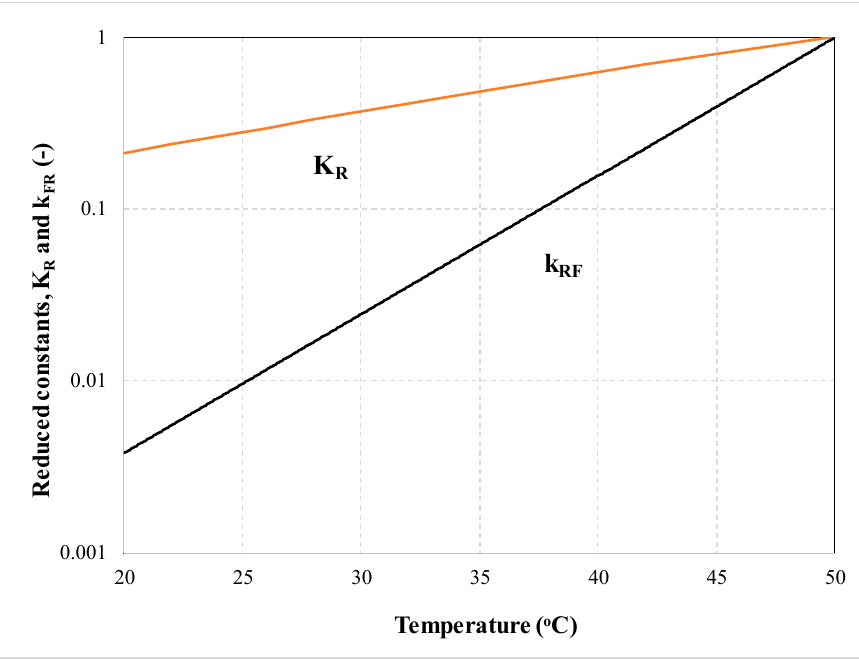
Figure 8. Variation of reduced constants, K R and k FR with temperature.